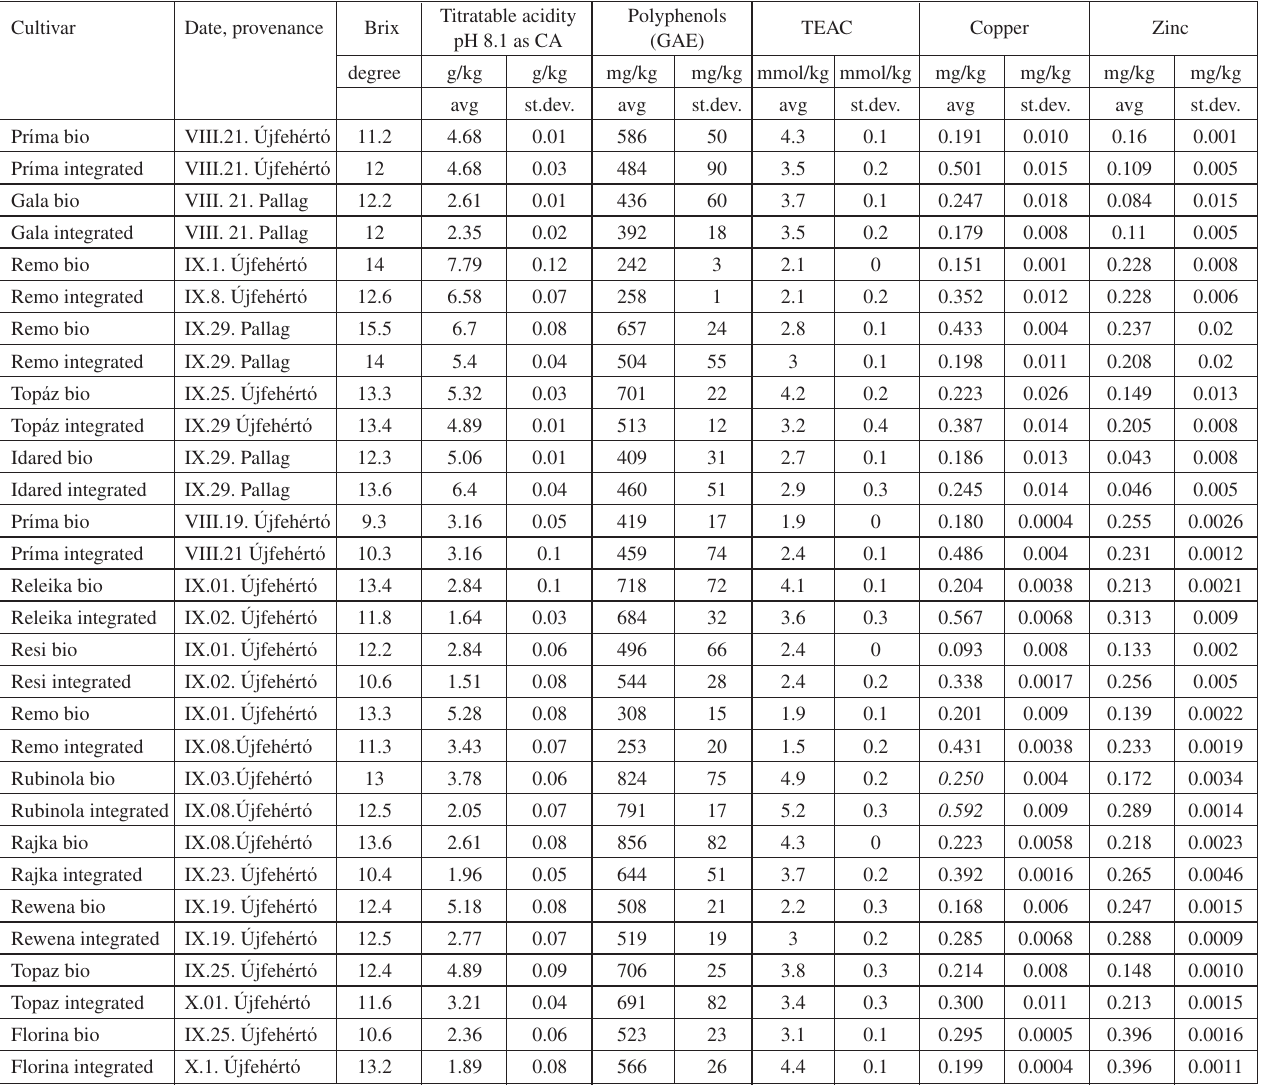
Table 3. Composition of apples at harvest and after